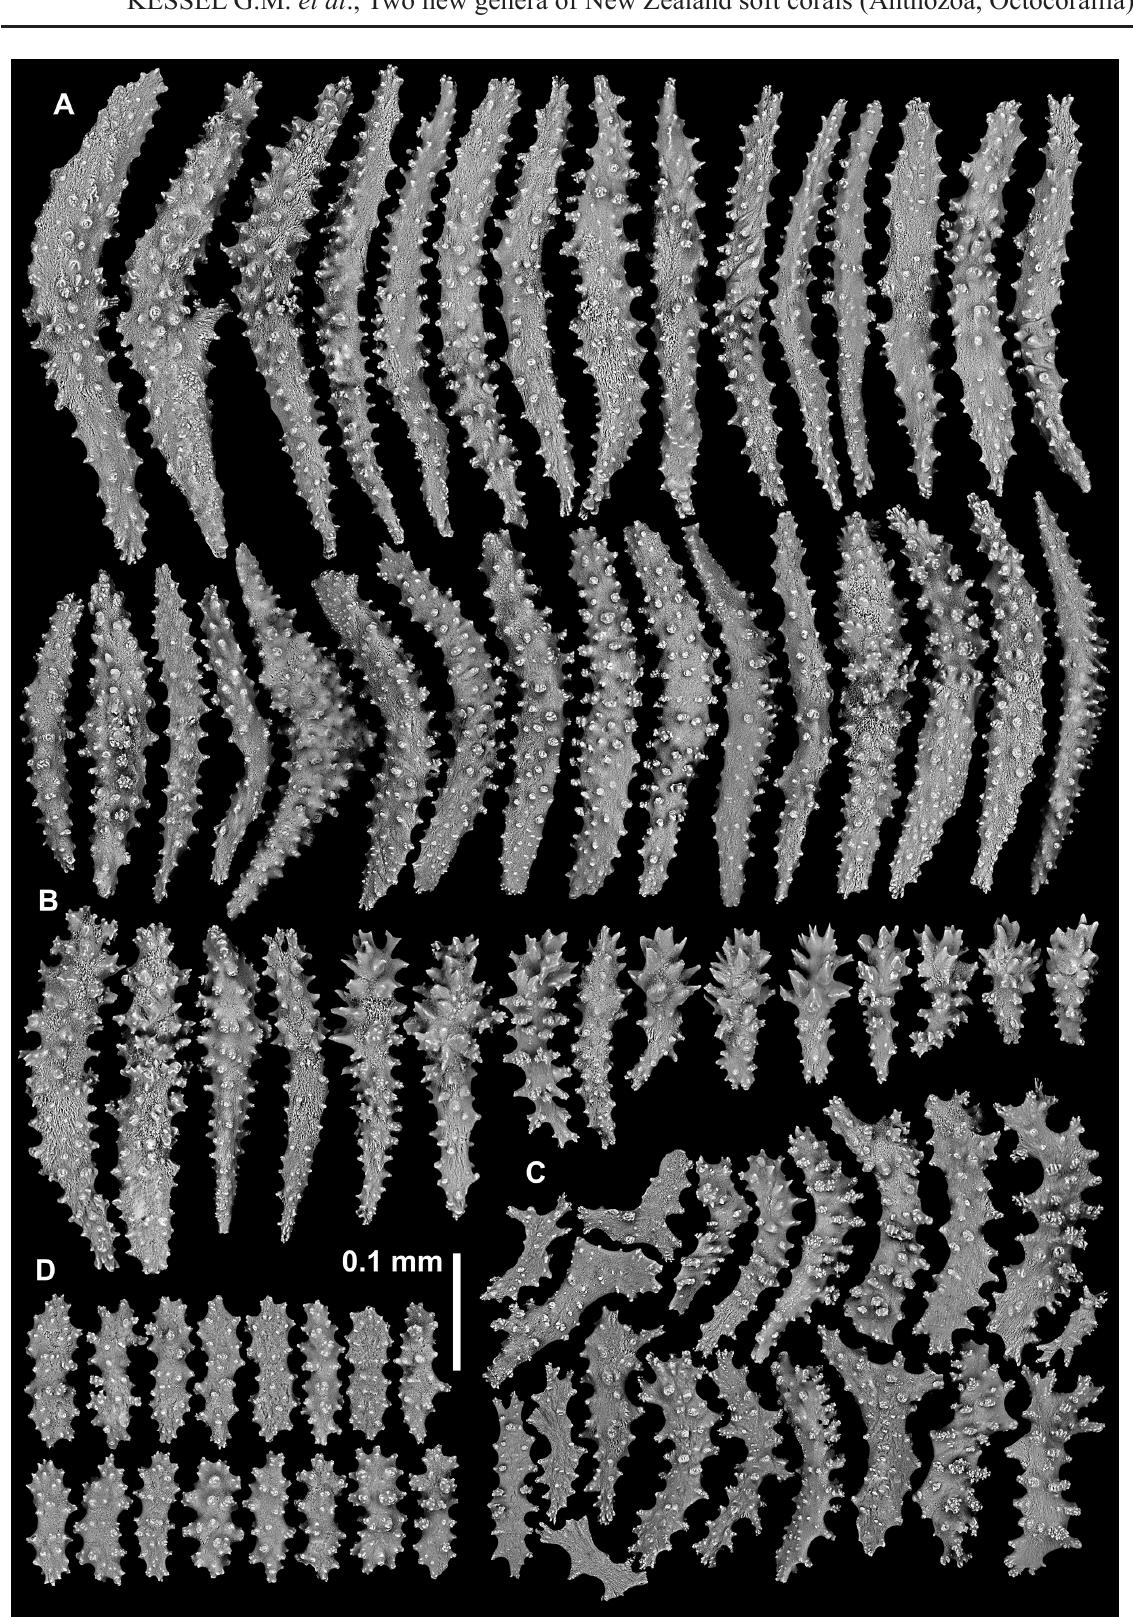
Fig. 15. Kotatea kurakootingotingo gen. et sp. nov., holotype (NIWA 101538), SEMs of sclerites. A . Collaret and points. B . Distal points. C . Tentacles. D . Polyp